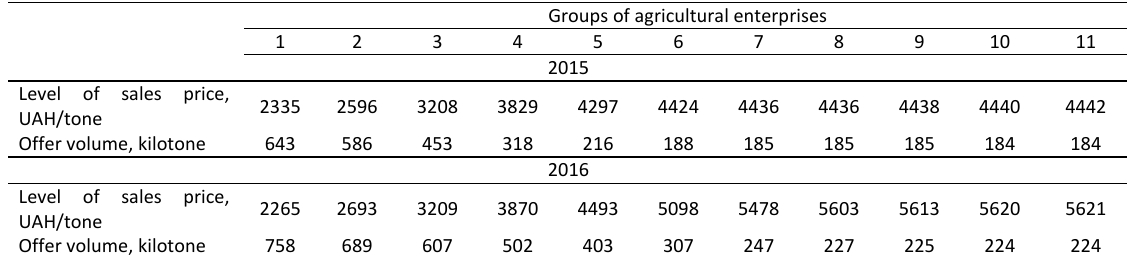
Table 5: Characteristics of the demand for milk for 2015-2016